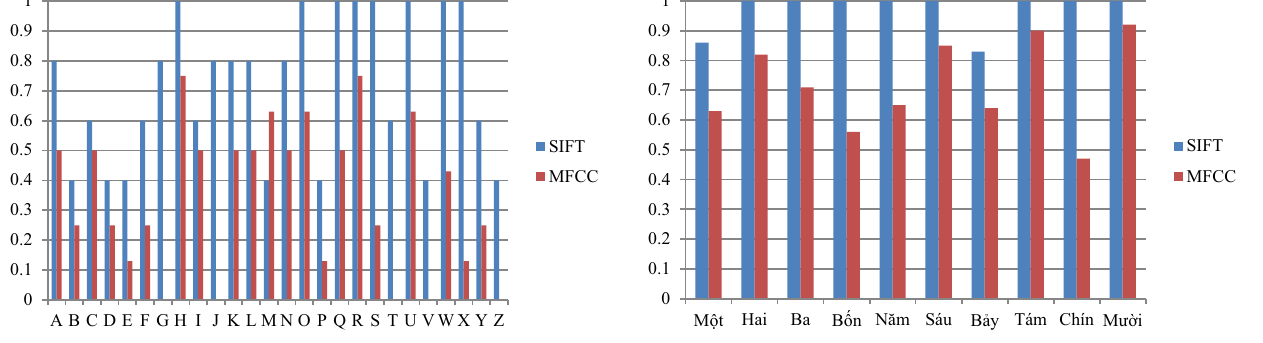
Fig. 11 Correct classification rate of LNBNN with MFCC and SIFT features on the Vietnamese digits database